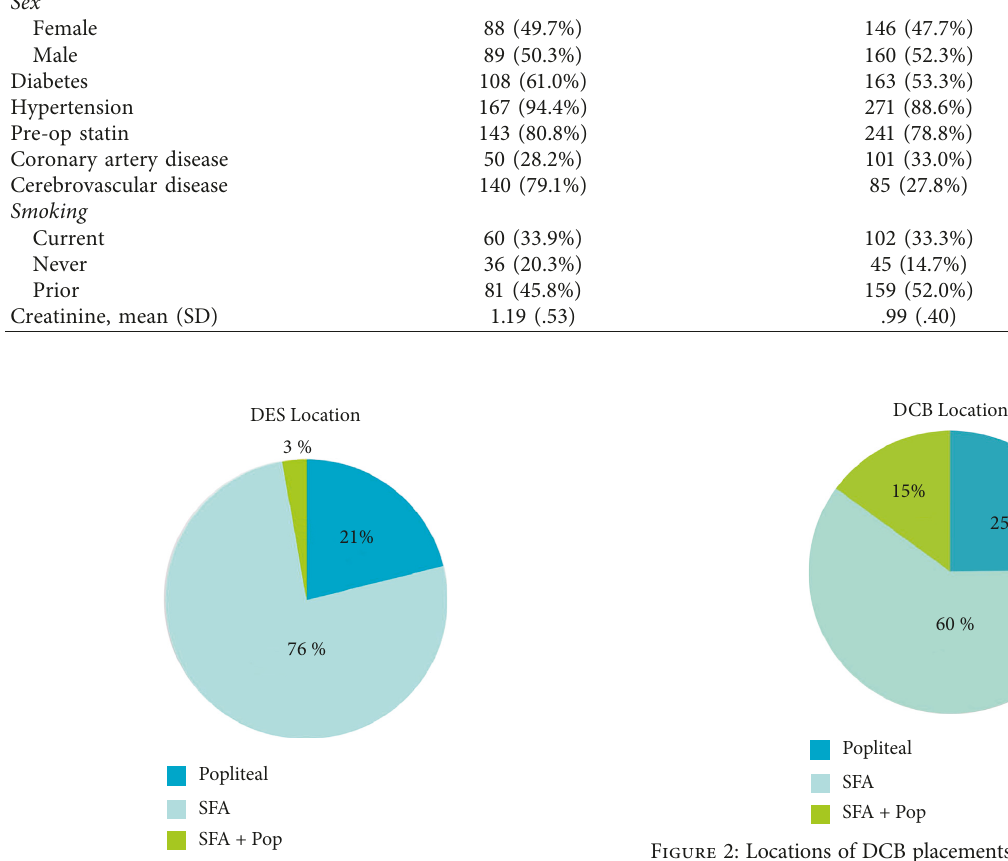
Figure 1: Locations of DES placement. SFA was the most common location for DES followed by the popliteal artery with a small subgroup undergoing DES to combination of SFA and popliteal. DES � drug-eluting stents; Pop � popliteal; SFA � superficial fem- oral artery.